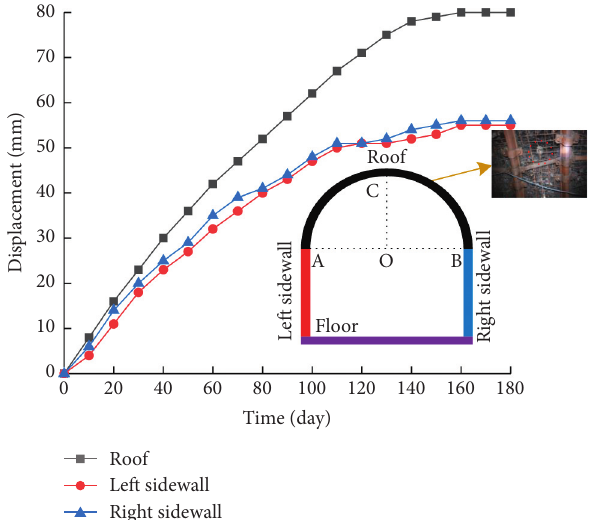
Figure 15: Roadway surface displacement